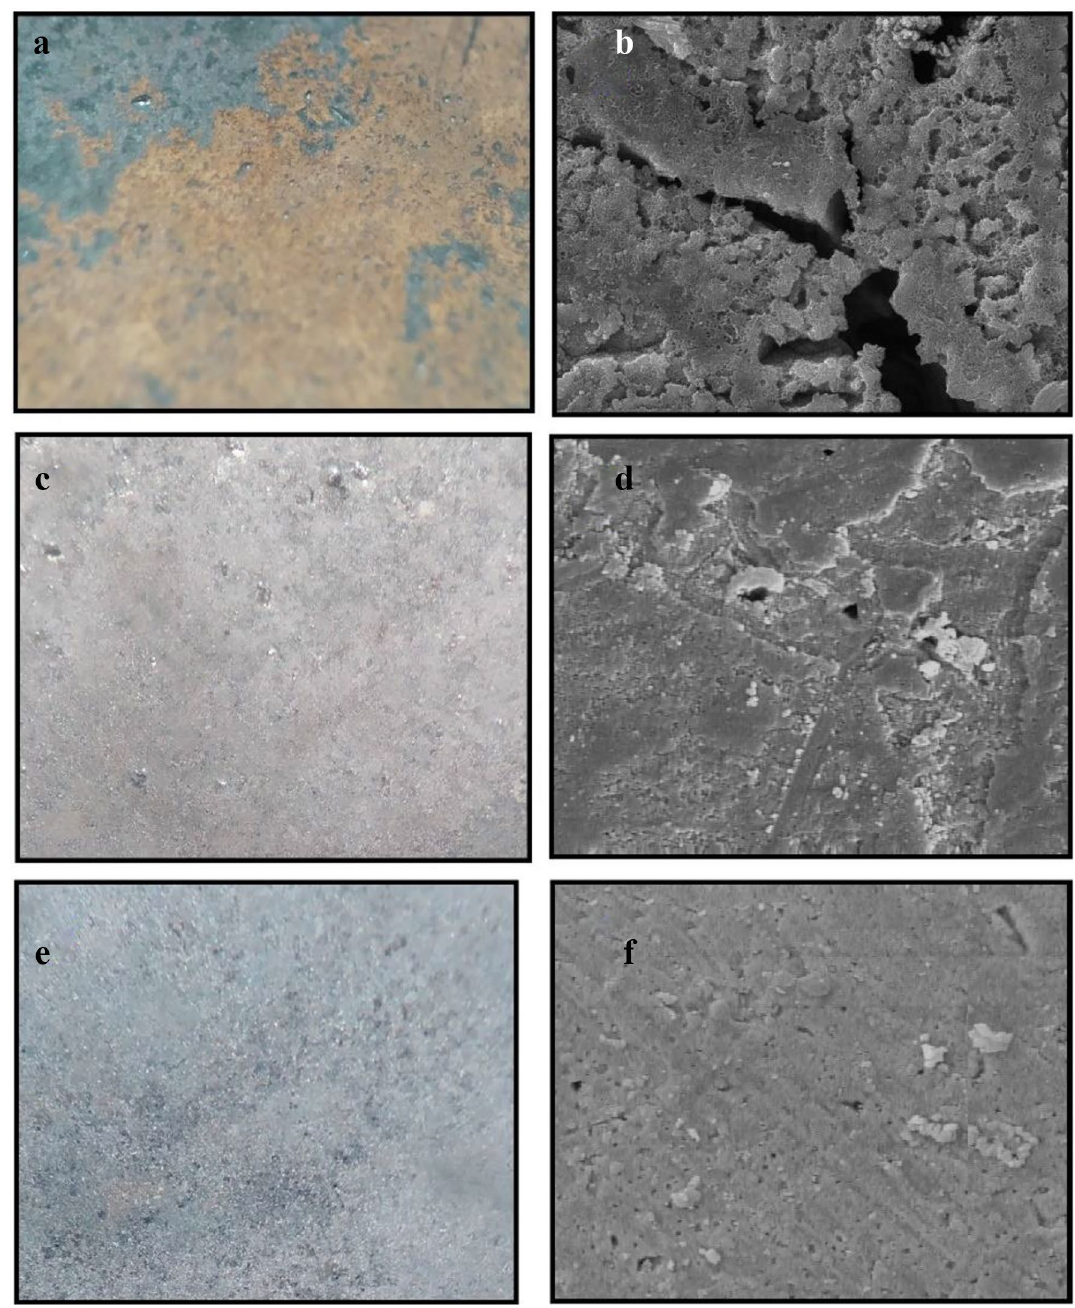
Figure 12. The images of the st-37 surface after 24 h immersion in 1.0 M HCl solution in the ( a , b ) absence, ( c , d ) presence of 400 ppm of Dracocephalum extract in bulk size ( e , f ), and presence of 100 ppm